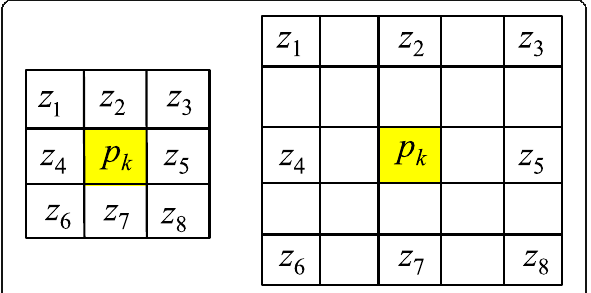
Fig. 4 Eight neighboring pixels in 3×3 and 5×5 windows around p k